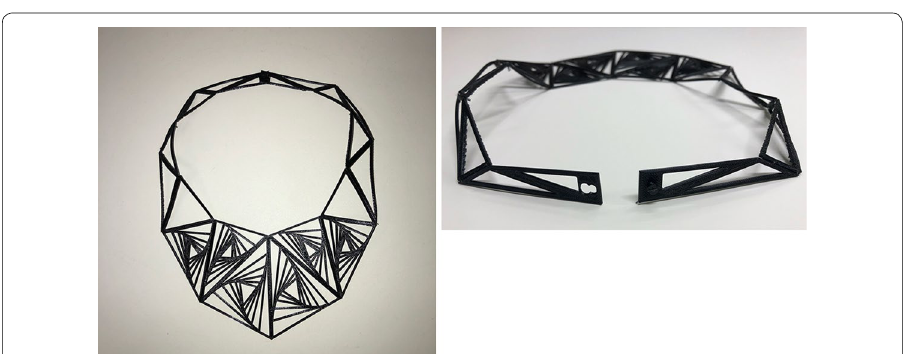
Fig. 15 a 3D printed necklace of Design 2 (left), b closure shape of necklace